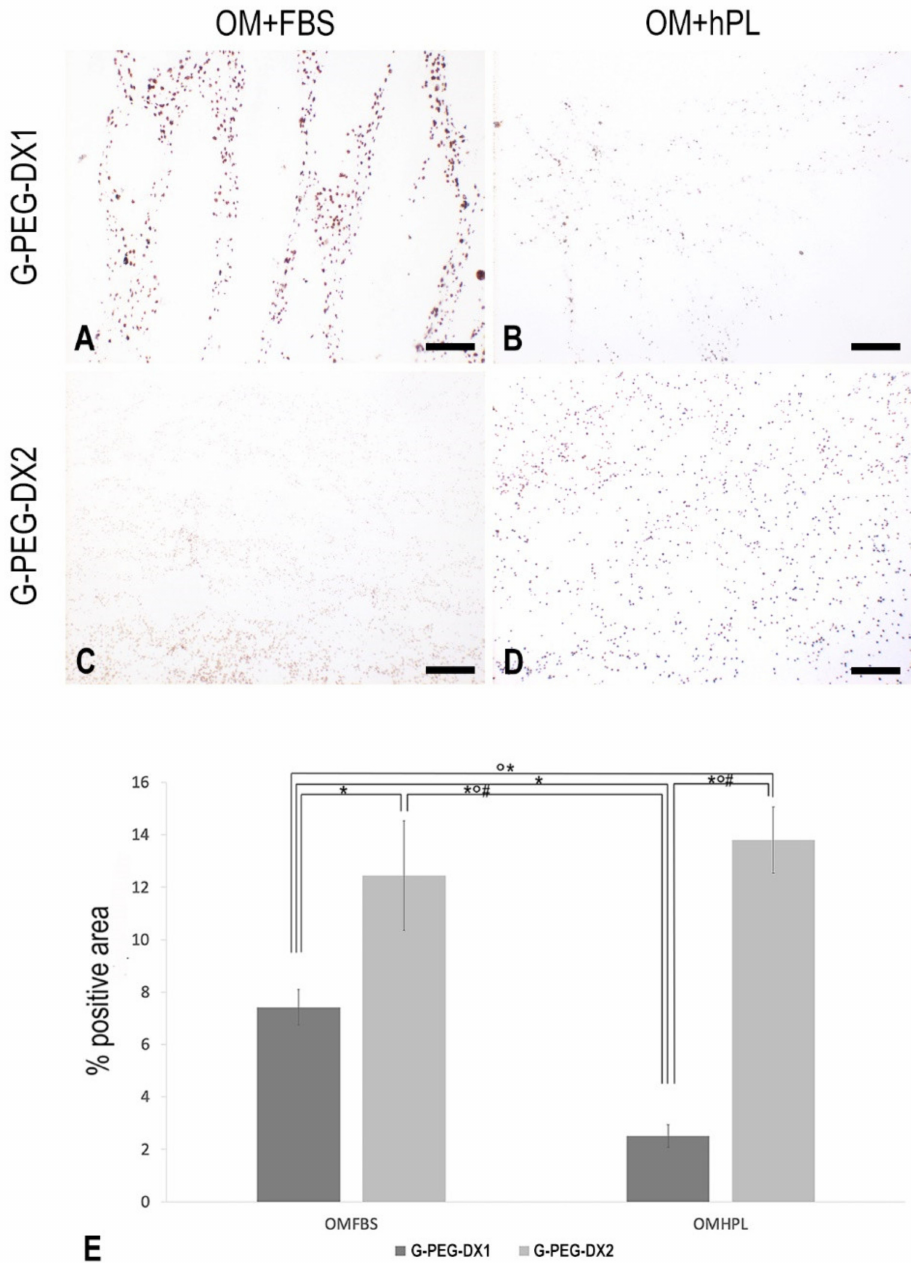
Figure 4. Calcium deposit distribution in hydrogels using Von Kossa stain. Microphotographs of G-PEG-Dx1 ( A , B ) and G-PEG-Dx2 ( C , D ) under the osteoinductive culture conditions: OM+FBS ( A , C ), OM+hPL ( B , D ). Calcium deposits appeared as dots in brown/black color. Scale bar: 100 µ m. Quantification of percentage of positive area within scaffold meshes ( E ); ◦ p < 0.05; * p < 0.01; # p <